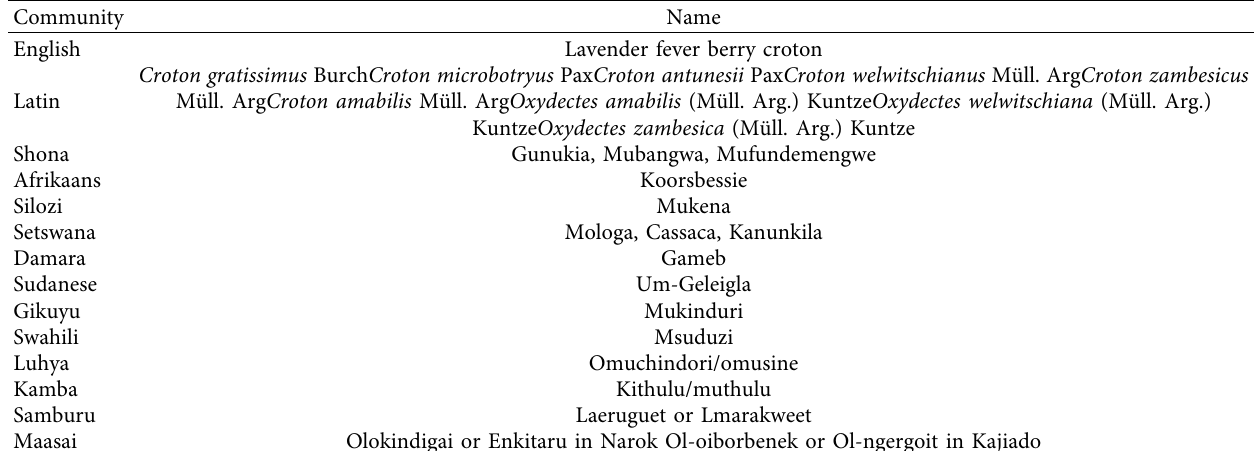
Table 1: Different names of Croton gratissimus [17,